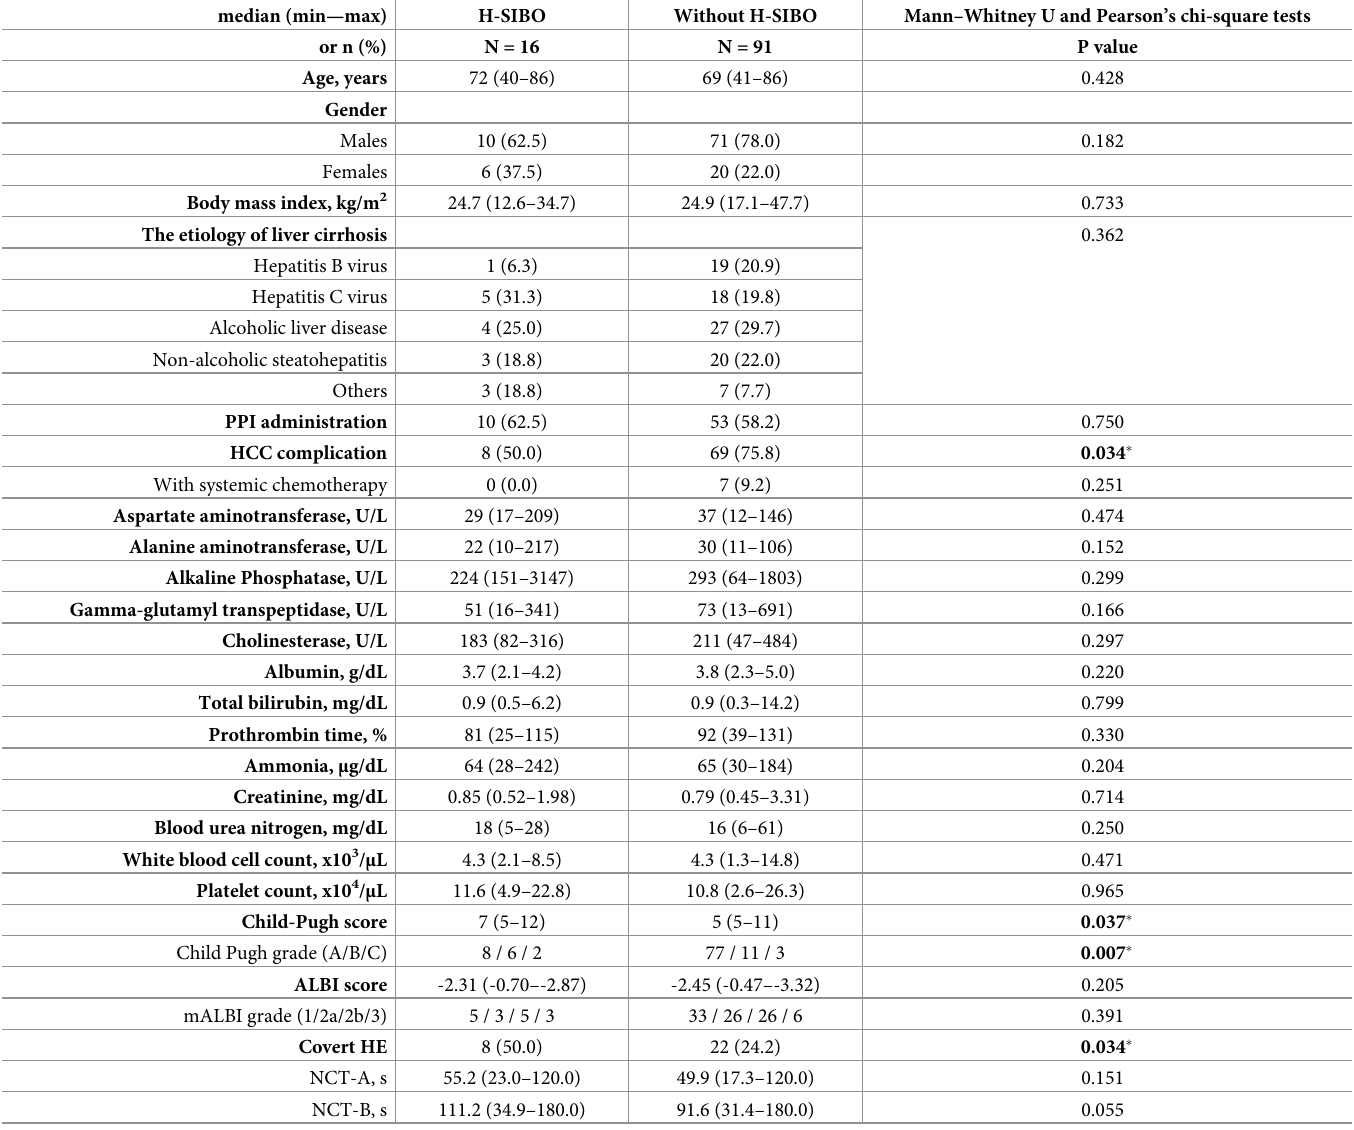
Table 2. Non-parametric tests clustered by